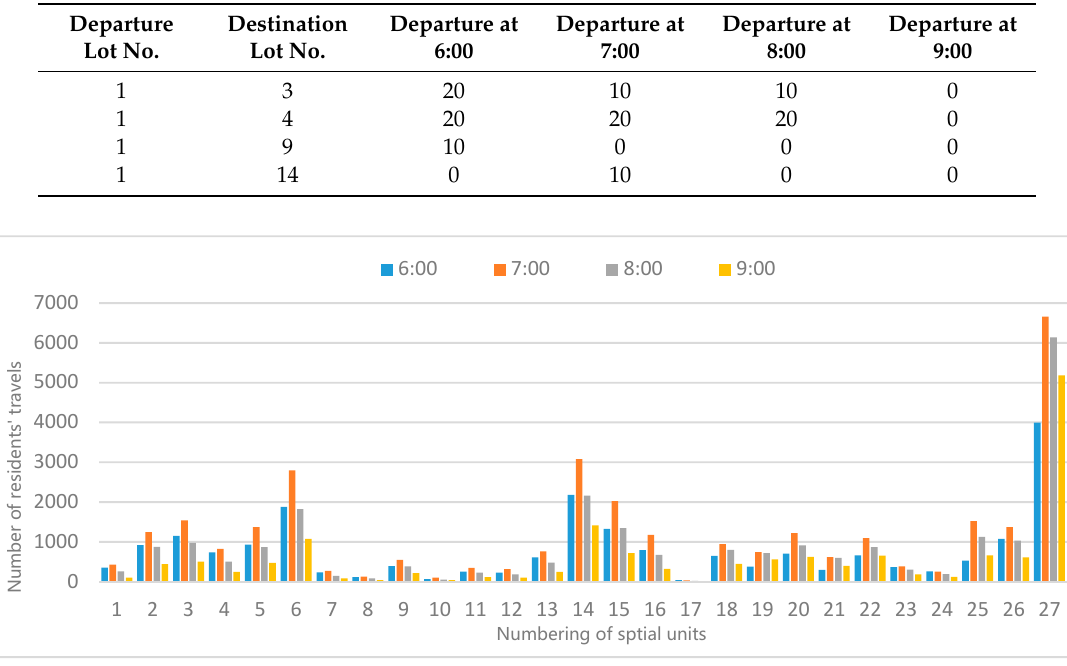
Figure 4. Comparison of residents’ travels at different hours in different spatial units.